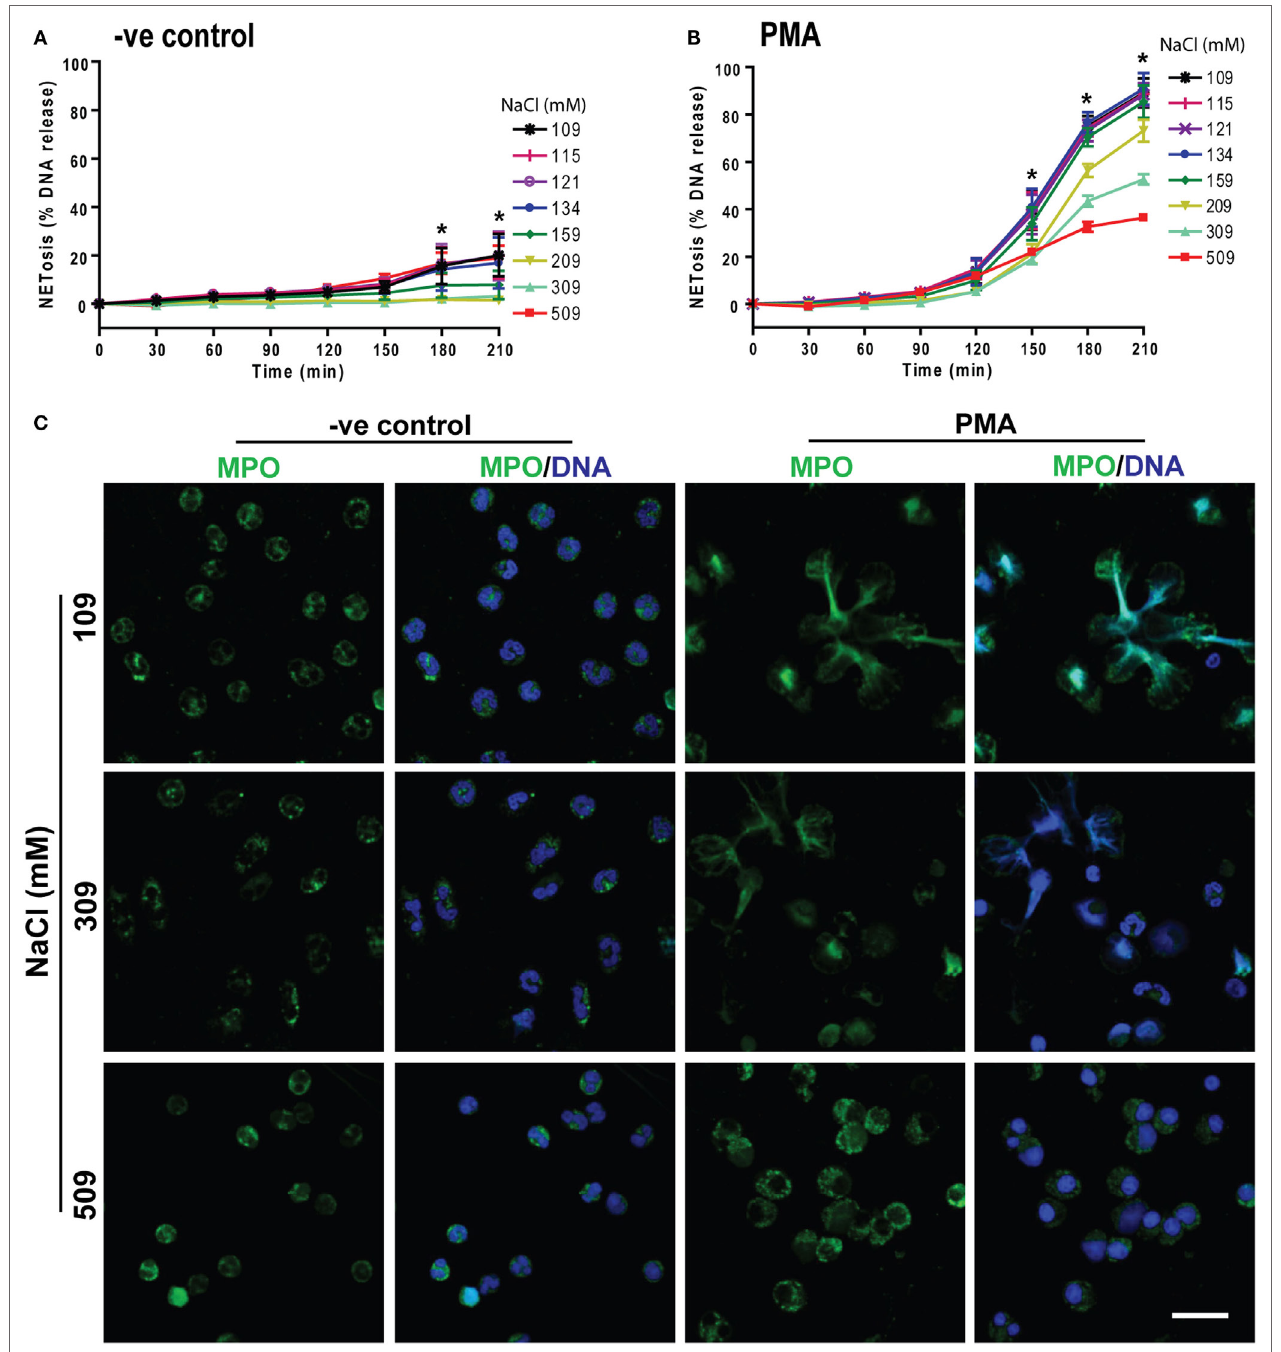
FigUre 1 | Increasing NaCl concentration suppresses phorbol myristate acetate (PMA)-mediated NETosis. NETosis assays were performed on human neutrophils resuspended in different NaCl concentrations (109, 115, 121, 134, 159, 209, 309, and 509 mM) with 5 µM Styox Green dye. These neutrophils were either unstimulated ( − ve control) or activated or by PMA (25 nM). The Sytox Green florescence intensities (proxy for DNA release) were recorded by a plate reader every 30 min up to 210 min. (a) % DNA release (NETotic index) show less NETosis in higher salt conditions in unstimulated neutrophils ( − ve control). (B) PMA treatment induces NETosis, and NaCl dose-dependently suppresses this form of NETosis. The suppression with NaCl concentrations at 309 mM and 509 mM is significant at several time points ( n = 3 − 5, * p < 0.05; two-way ANOVA with Bonferroni’s multiple comparison post test). (c) Confocal microscopy of neutrophils with media only ( − ve control) or PMA-treated in different salt conditions (109, 309, and 509 mM) were performed. Neutrophils were stained for DNA and myeloperoxidase (MPO); colocalization of the two signifies NETosis of neutrophils. Negative control neutrophils show no substantial neutrophil extracellular trap (NET) release, and higher NaCl conditions suppress the background NETosis. Drastic suppression of NETosis can be seen in PMA-treated neutrophils at 509 and 309 mM, but not in 109 mM salt conditions ( n = 3 − 5; MPO-green; DNA-DAPI; scale bar, 22 µm). See Figure S1 in Supplementary Material for IgG isotype antibody and Figure S2 in Supplementary Material for more salt conditions, low magnification